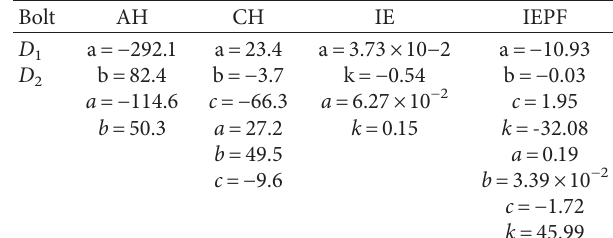
Table 17: Model parameters for example 4.